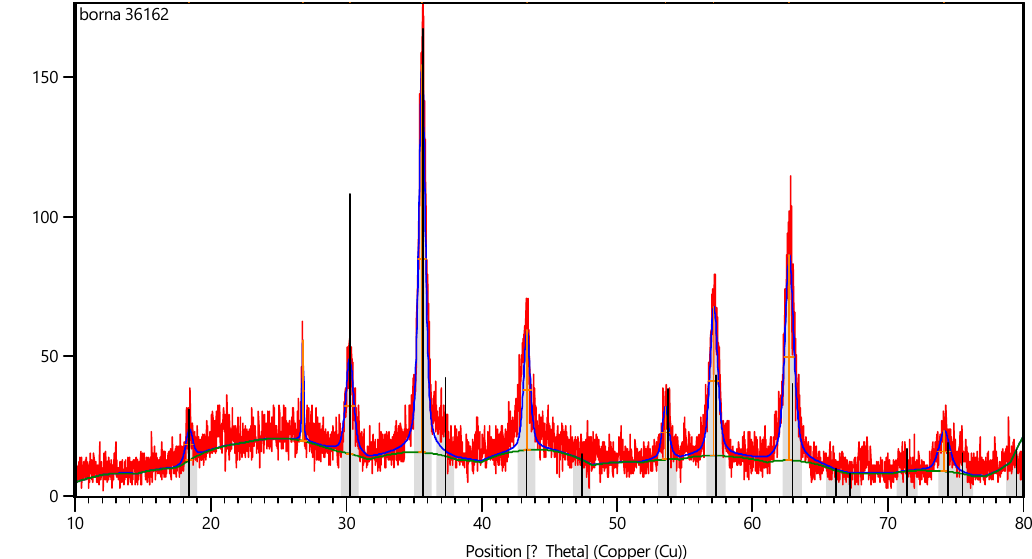
Figure 2. The XRD of activated carbon/CoFe 2 O 4 nanocomposite.